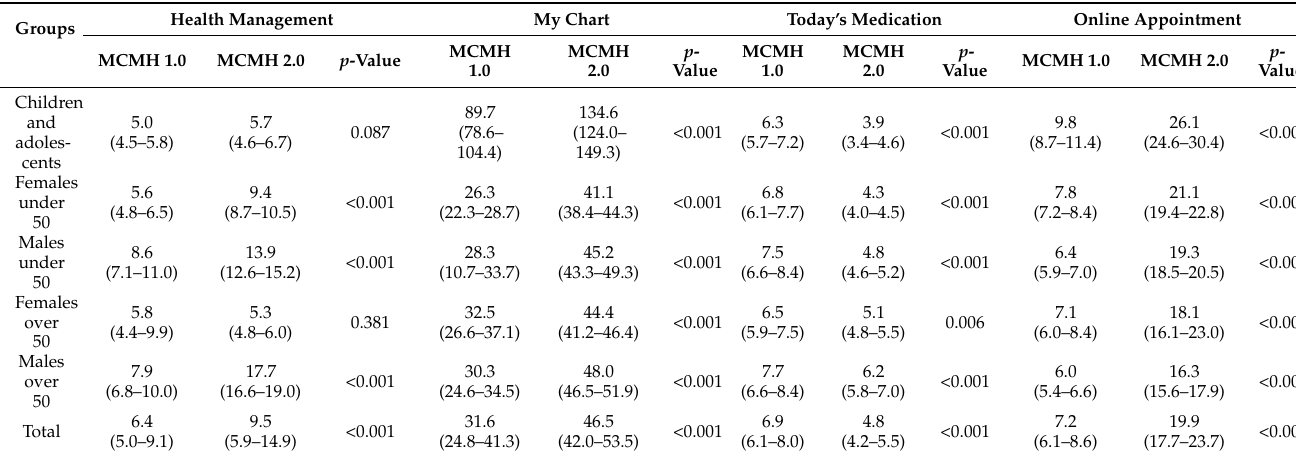
Table 4. Median values of monthly average access counts in MCMH 1.0 and MCMH 2.0 according to age and sex groups.